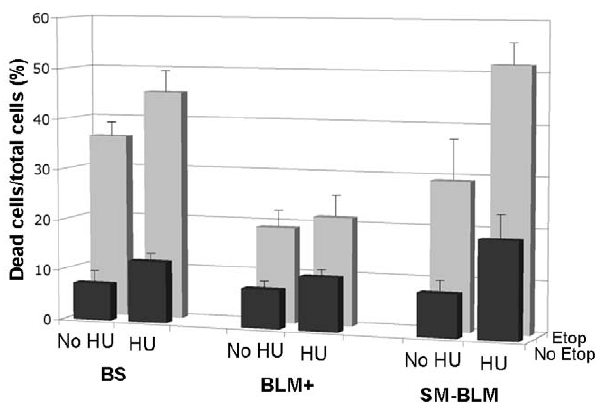
Figure 3. SM-BLM cells are hypersensitive to DNA damage encountered during S phase. Cells were untreated (NT) or treated with 0.5 mM HU for 24 h and then untreated or treated with 50 m M etoposide for 24 h. Cell viability was measured using the Guava ViaCount reagent, and cell death was calculated as the percentage of dead cells divided by the total number of cells. The bars represent the mean percentage of dead cells in each condition in three BLM + clones and three SM-BLM clones from a minimum of three independent experiments performed in triplicate. Error bars represent standard deviations of the combined data. See text for p -values of relevant comparisons.